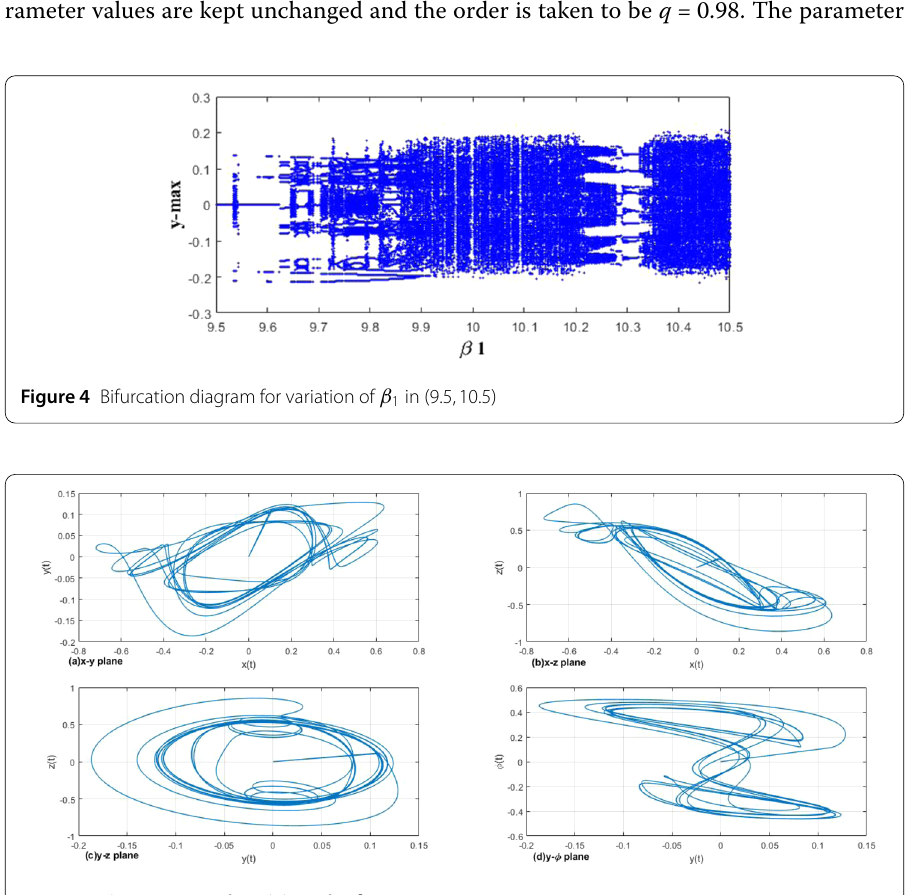
Figure 5 Phase portrait of model (21) for β 1 =